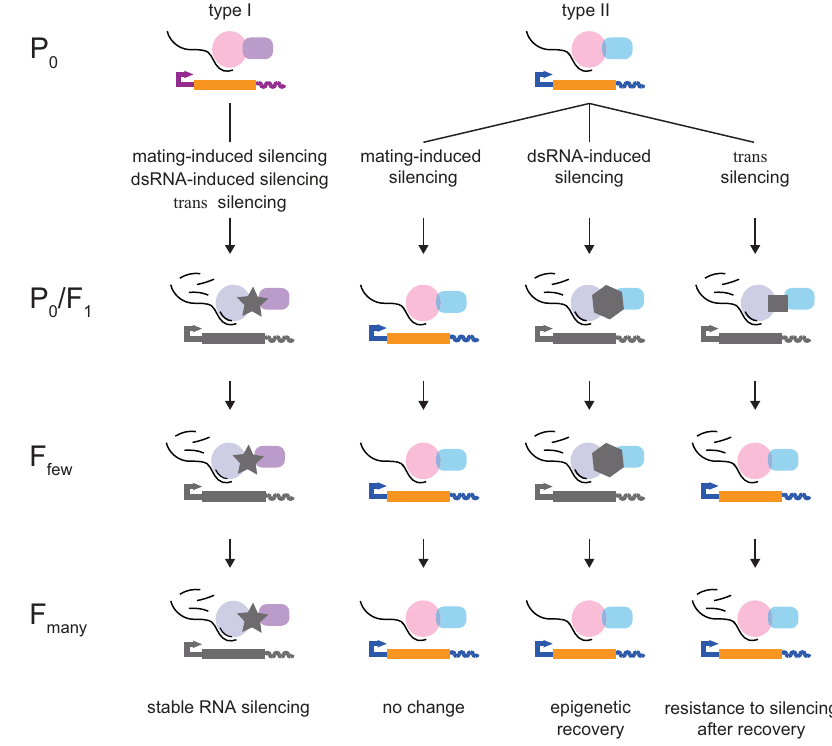
Fig. 7 Model depicting two types of genes with distinct transgenerational regulation. Type I genes stably express a recombinant sequence ( T, Tcherry, Tgfp , etc. described in this study) and yet can undergo permanent heritable change upon RNA silencing initiated using one of multiple methods